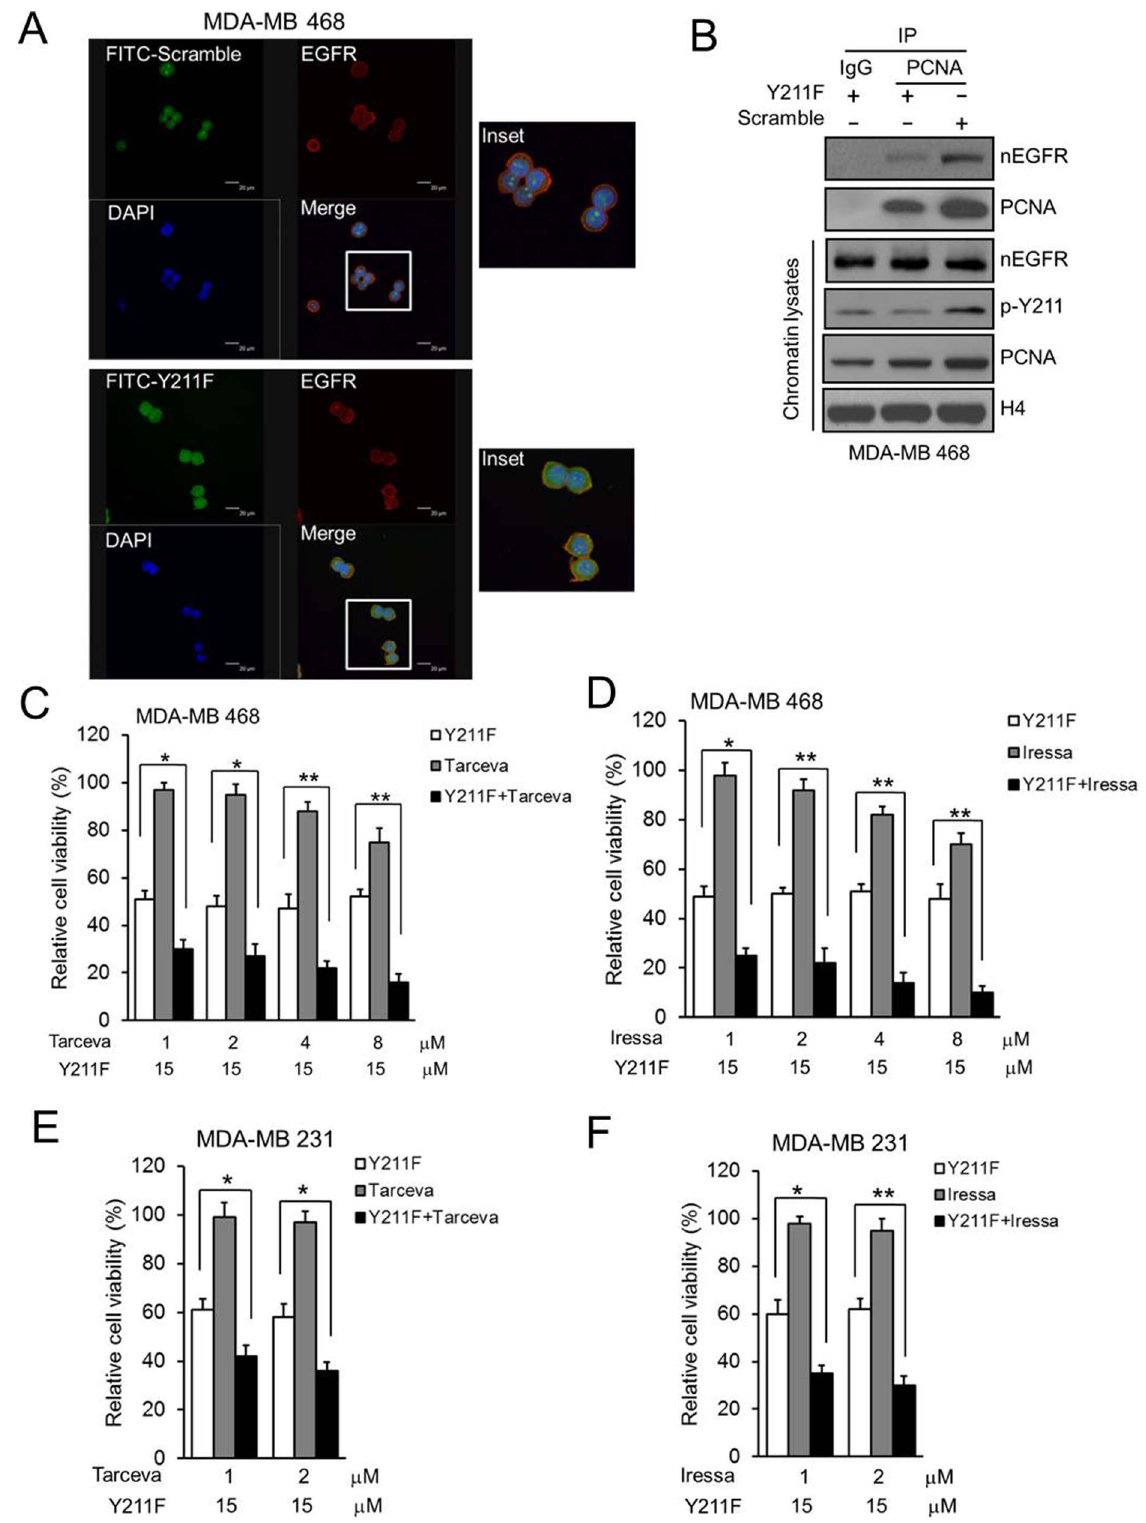
Figure 2. The effect of CPPP on PCNA Y211 phosphorylation and EGFR TKIs. (A) MDA-MB 468 cells were treated with 30 m M FITC-labeled scrambled (FITC-Scrambled; top) or Y211F CPPP (FITC-Y211F; bottom) for 12 h. Subsequently, cells were fixed, permeabilized, and stained with anti- EGFR antibody or DAPI. The fluorescent images were observed under a confocal microscopy. The FITC-labeled peptide (green), EGFR (red), and nucleus (blue) are shown. (B) MDA-MB 468 cells were treated with 30 m M scrambled (Scramble) or Y211F CPPP (Y211F) for 24 h. The chromatin lysates were extracted and IP with IgG or anti-PCNA antibody and separated by SDS-PAGE followed by IB for nEGFR, Y211-phosphorylated PCNA (p-Y211) and PNCA in MDA-MB 468 cells. (C–F) Both MDA-MB 468 or MDA-MB 231 cells were treated with 15 m M Y211F CPPP or 1 , 8 m M EGFR TKI (Tarceva or Iressa) alone, or Y211F CPPP and TKI combined for 24 h. The relative cell viability after each treatment was then determined. doi:10.1371/journal.pone.0061362.g002 PLOS ONE |